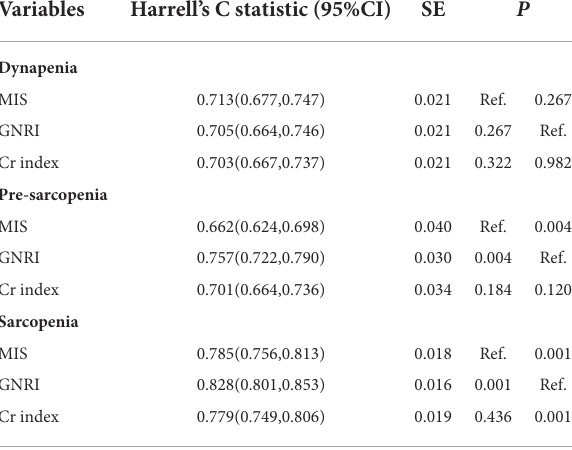
TABLE 4 Results of the Harrell’s C